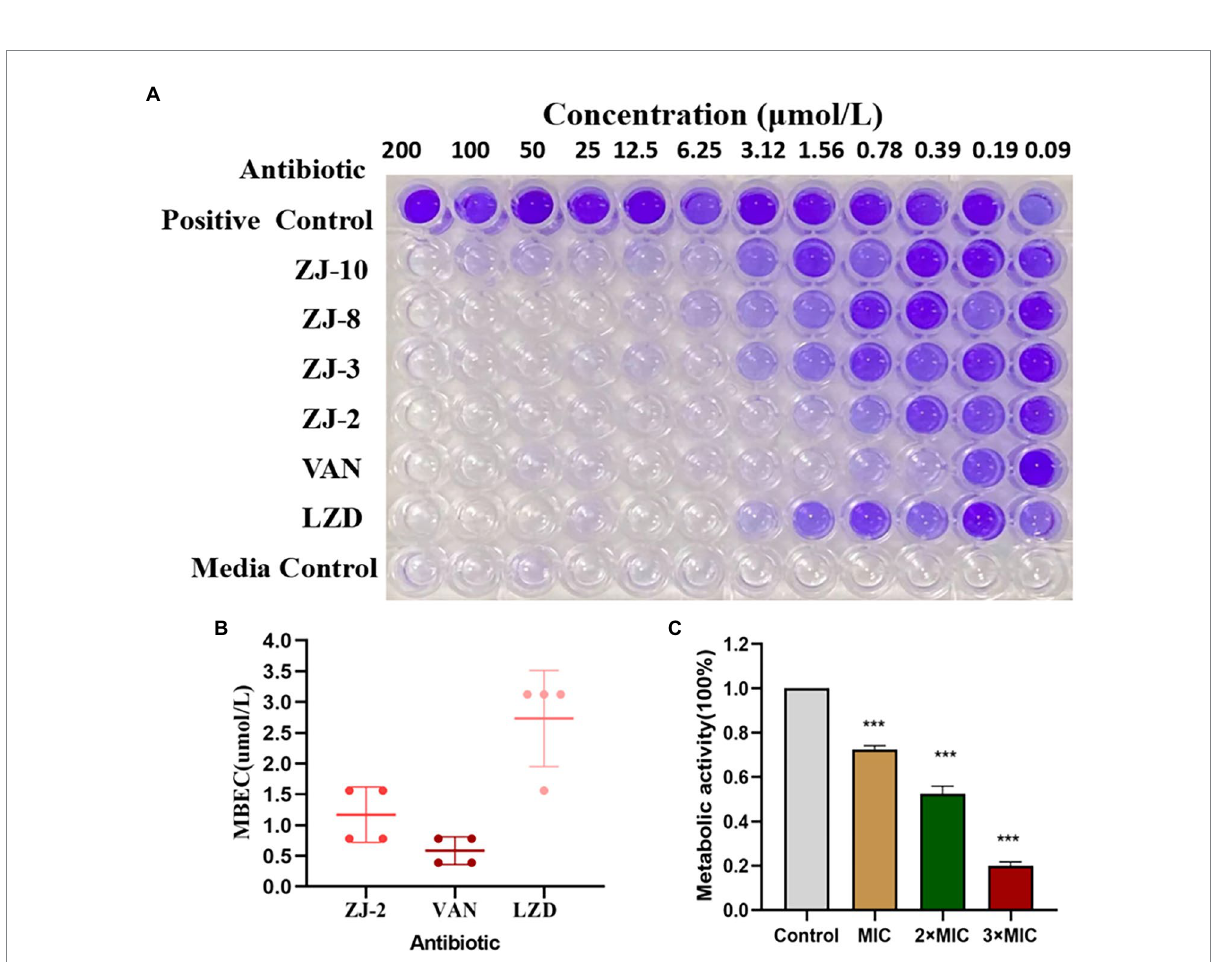
FIGURE 4 CV assay and XTT reduction assay. MBEC assessment of ZJ-2 using crystal violet staining (A) to assess (B) E. faecium E3101 biofilm remaining after 24 h incubation with ZJ-2 , vancomycin and linezolid (biofilm initially established by 48 h growth in TSB + 5% glucose). XTT reduction assay (C) to attenuate the metabolism of E. feacium biofilm After 24 h treatment of the established biofilms with ZJ-2 . Each OD point presented is the average values of 4 tests. *** p <